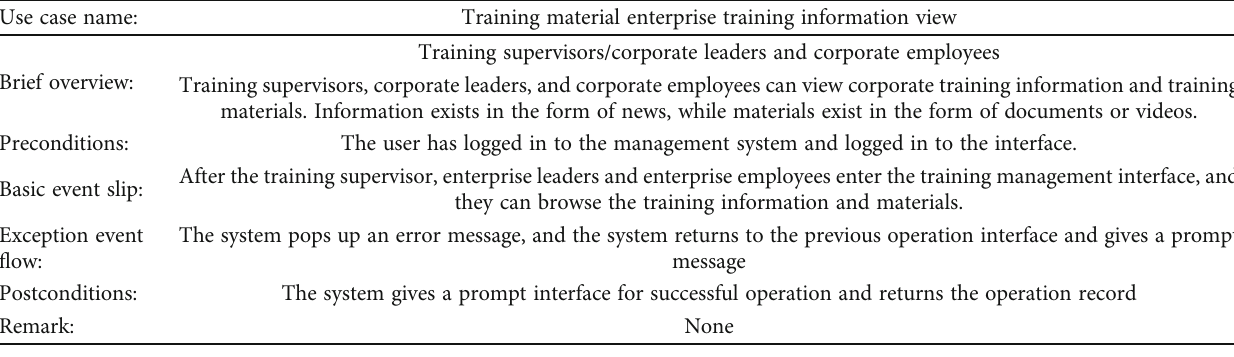
Table 1: Training information view use case speci fi cation table.